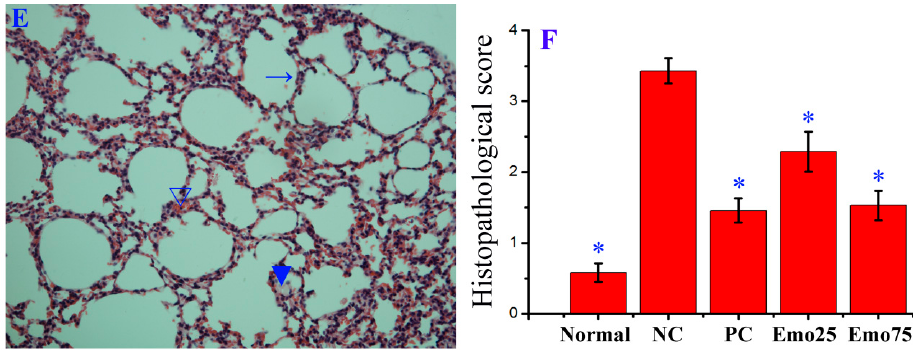
Figure 7. Influence of emodin on the histopathological changes. Mice were treated as Figure 6 mentioned. At day 6 p.i., six mice from each group were sacrificed. The right sides of the lungs were used in haematoxylin and eosin (H&E) staining assay. ( A ) Uninfected control (Uninfected); ( B ) Negative control (DMSO); ( C ) Positive drug control (Oseltamivir); ( D , E ) Emodin-treated groups (Emo25 and Emo75, respectively). ( → ) alveolar wall, ( ▼ ) inflammatory exudation, ( ∇ ) hemorrhage (erythrocytes). The magnification was 200×; ( F ) Histopathological score. Data shown were the mean ± SD. n = 6. * p < 0.05 vs. the DMSO control.